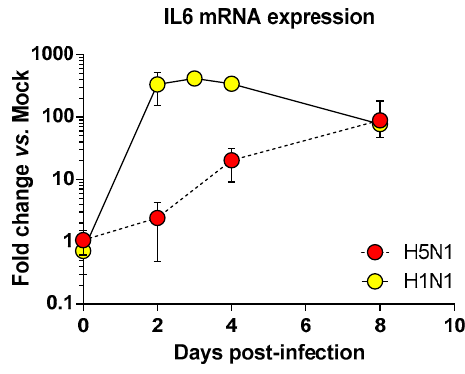
Figure 4. Time course of IL6 mRNA expression in the airways of infected mice. Mice were infected with 1.4 × 10 2 PFU and 1.5 × 10 5 PFU of H5N1 or H1N1 respectively and were euthanized at two, four, and eight days pi. After extraction, lung total RNAs were reverse transcribed and used to quantify IL6 transcription. IL6 mRNA levels were normalized to β -actin mRNA levels and presented as fold increase relative to mock-treated mice.